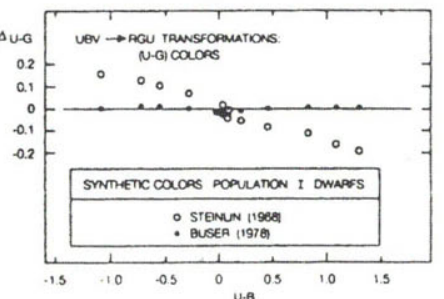
Fig. 12c. Residuals between the U-G colors transformed from UBV , according to Steinlin (1968) or Buser (1978b) and those synthesized from the stellar flux